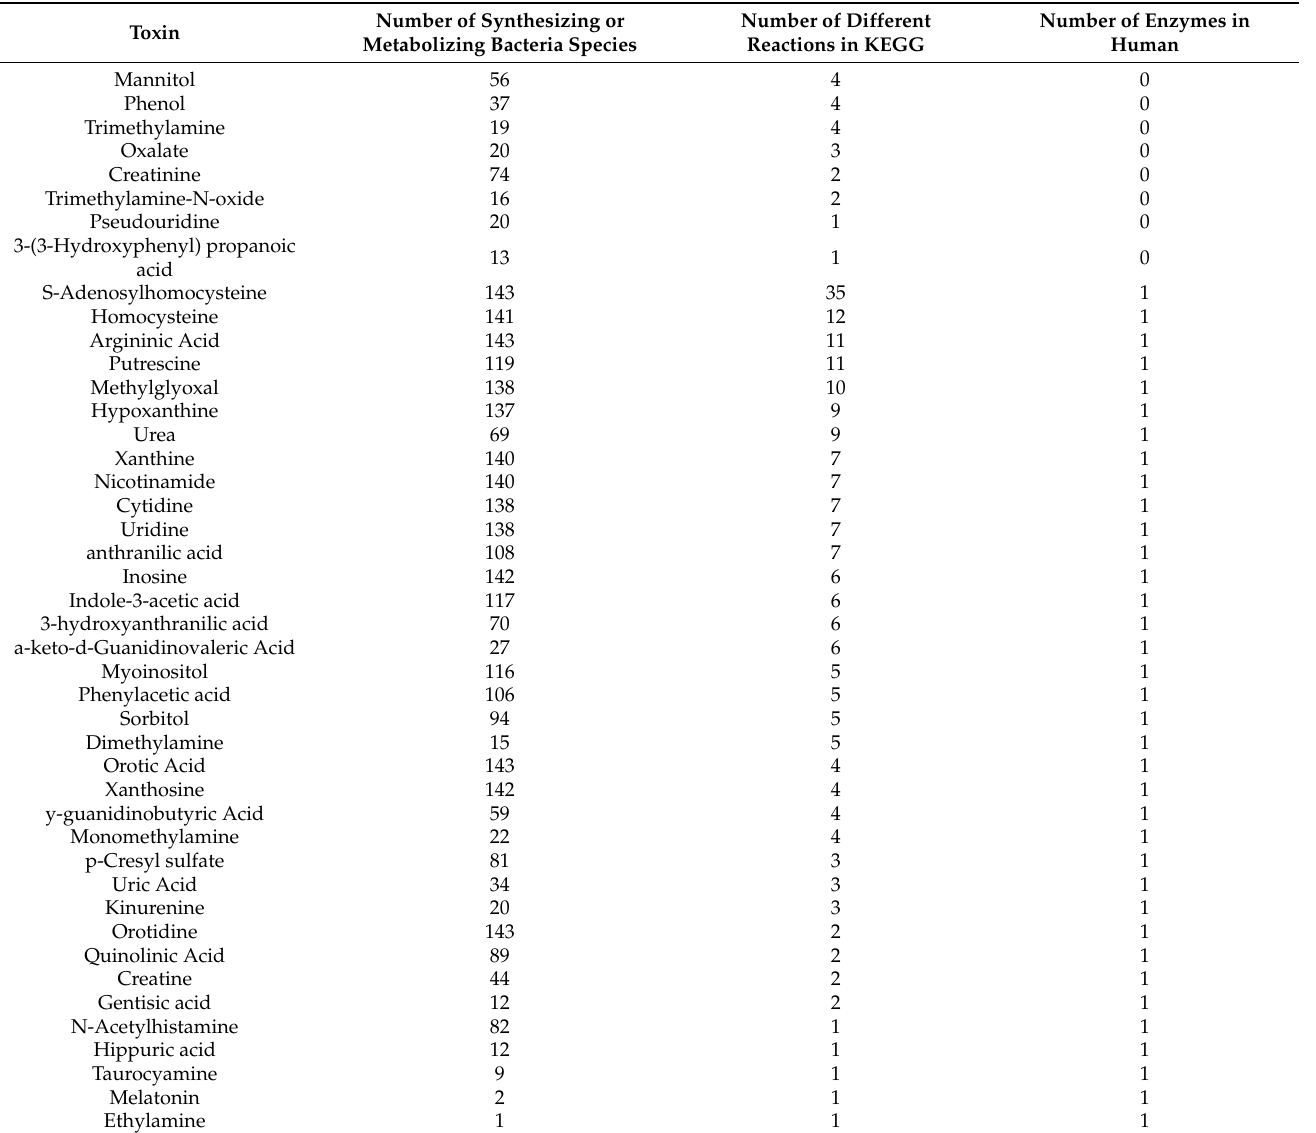
Table 1. Potential synthesis and metabolism of uremic retention solutes by microbiome bacteria species and human